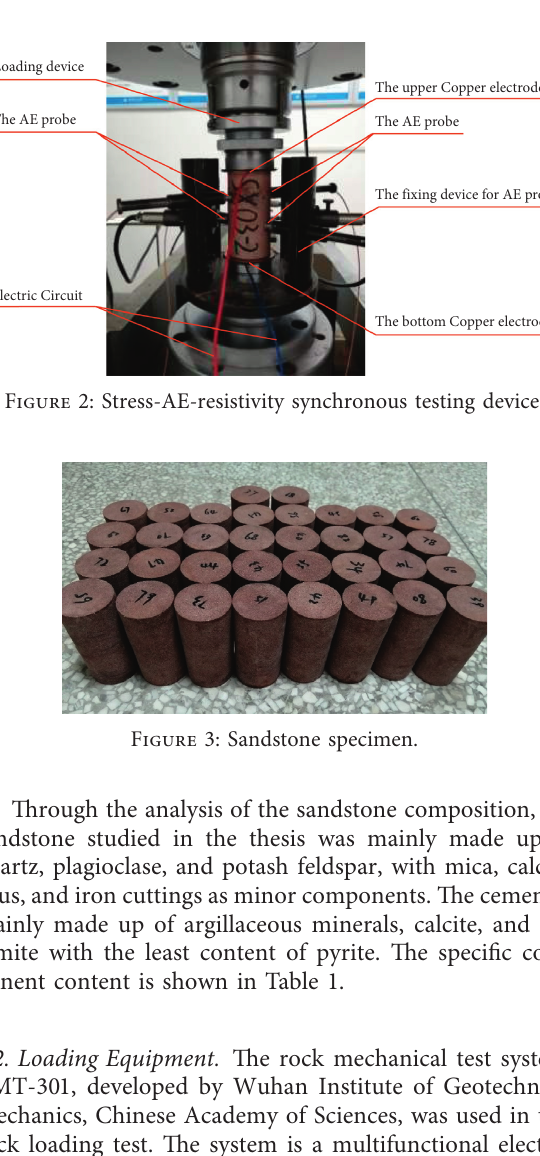
Figure 1: Test system design.